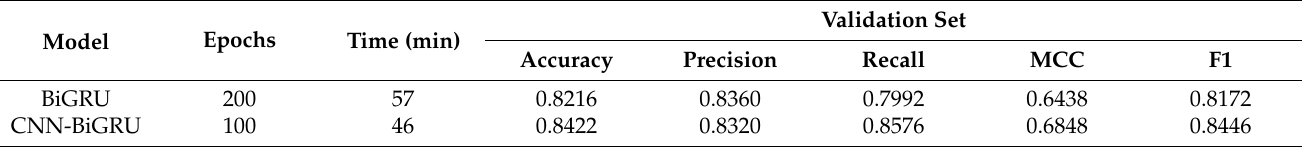
Table 2. Comparison of BiGRU and CNN-BiGRU performance on validation